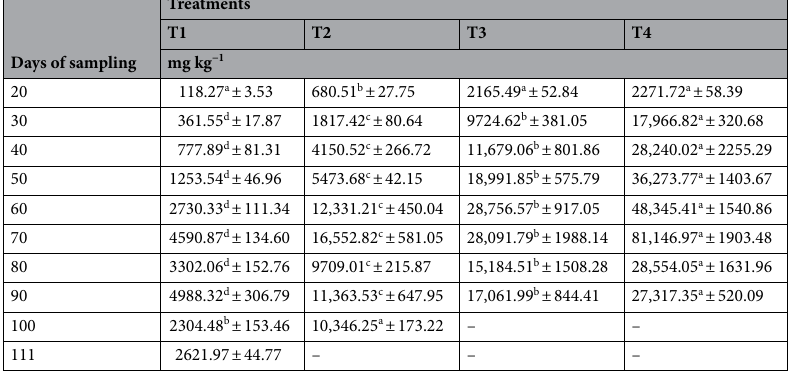
Table 13. Chicken litter biochar on plant uptake of total phosphorus at one hundred and eleven days of MR219 cultivation. Different letters within a row indicates significant difference between means of four replicates ± standard error using Tukey’s test at p ≤ 0.05.